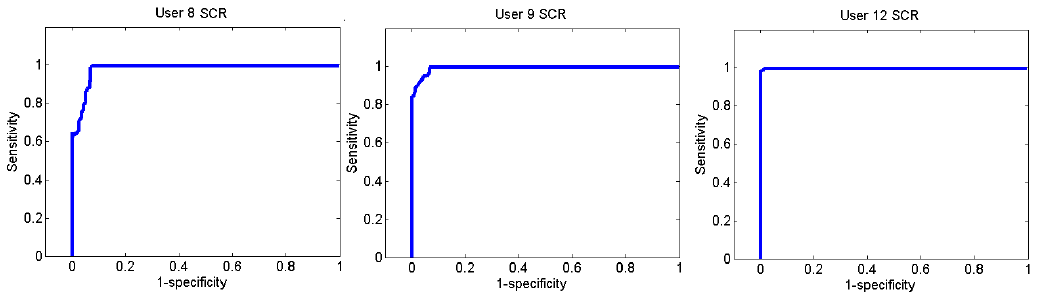
Figure 27. ROC curve of users 8, 9 and 12 from the Stoop Test.